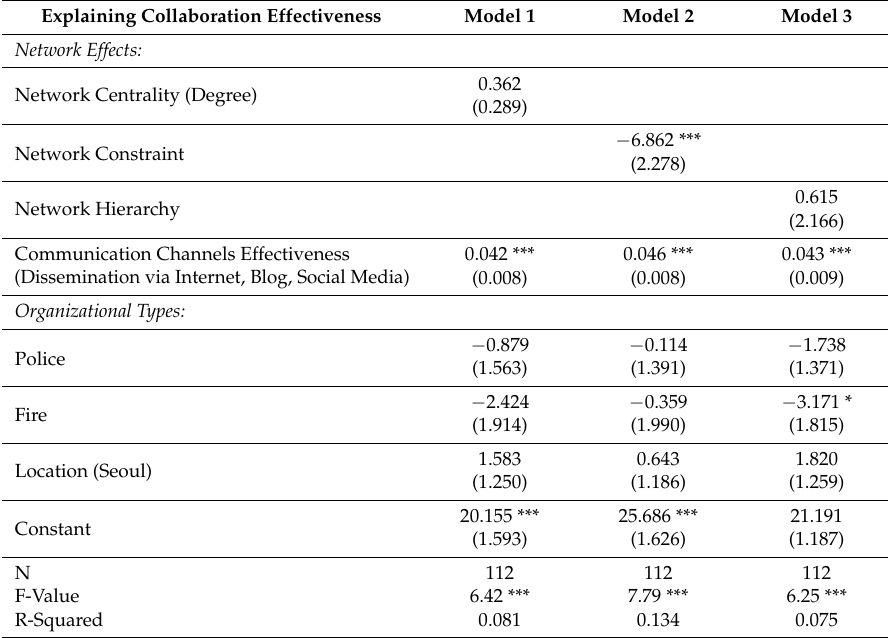
Table 4. Explaining collaboration effectivenesss (all cases).